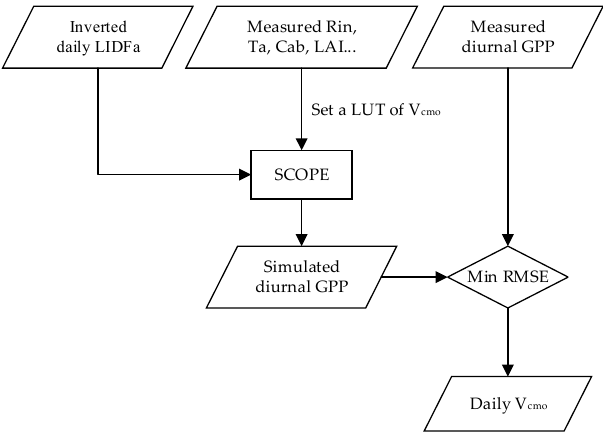
Figure 3. Schematic overview of the V cmo inversion procedure.